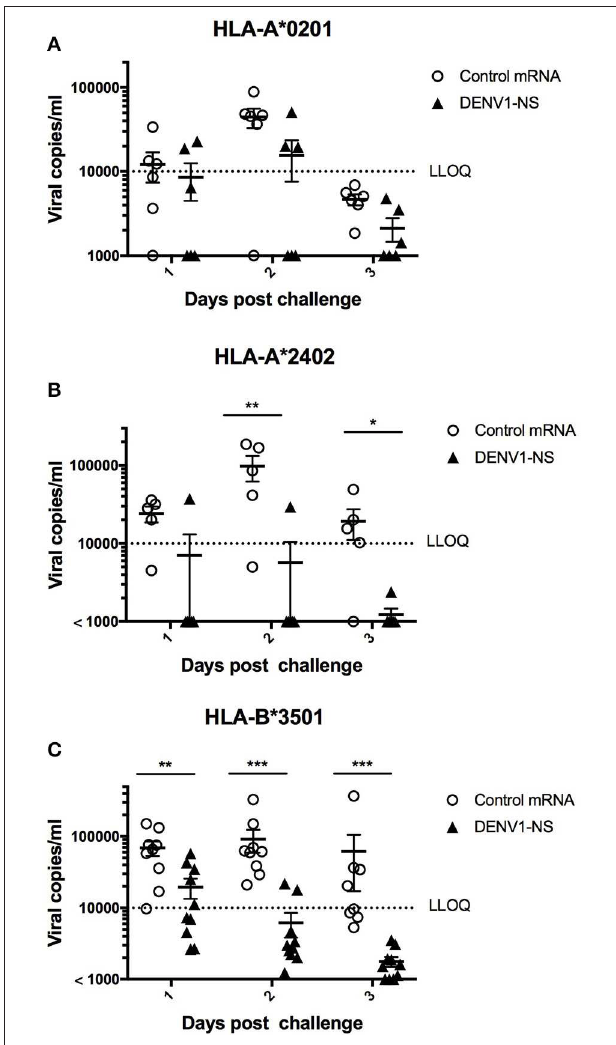
FIGURE 5 | Immune protection induced by immunization with the LNP-based mRNA encoding DENV1-NS. (A) Two groups of 6 HLA-A*0201 transgenic mice were immunized with the LNP-based mRNA encoding DENV1-NS or control mRNA, (B) Five and six HLA-A*2402 transgenic mice received the LNP-based mRNA encoding DENV1-NS and control mRNA, respectively, (C) Nine and ten HLA-B*3501 transgenic mice received the LNP-based mRNA encoding DENV1-NS and control mRNA, respectively. Mice were immunized by intramuscular injection of 10 µ g LNP-based mRNA encoding DENV1-NS or control mRNA, at day 0 and at day 28. One day prior challenge with the virus, mice received 1 intraperitoneal inoculation of 2mg anti-IFNAR antibody (MAR1-5A3) and they were challenged at day 56 by retro-orbital injection of 10 6 pfu DENV1 (KDH0026A strain). Quantification of virus replication in plasma samples was performed by qRT-PCR at days 1, 2, and 3 after the challenge. LLOQ: Lower limit of quantitative detection. Lines represent mean and SEM. Differences between mice immunized with the DENV1-NS vaccine and the CT vaccine were evaluated using non-parametric